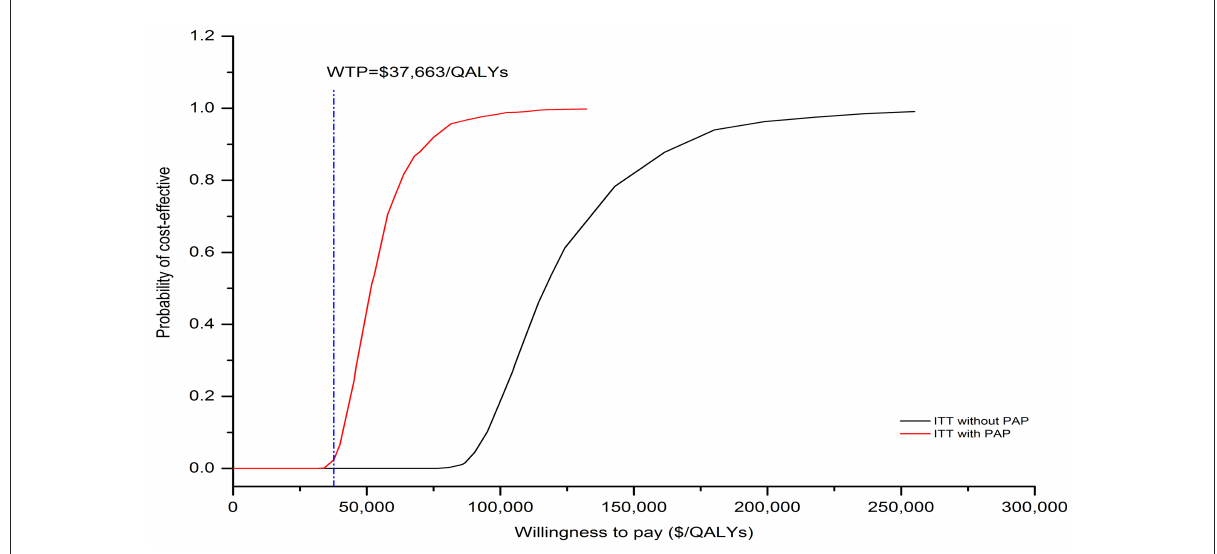
FIGURE4 The cost-effectiveness acceptability curves for SC strategy compared to the PC strategy without PAP and with PAP.